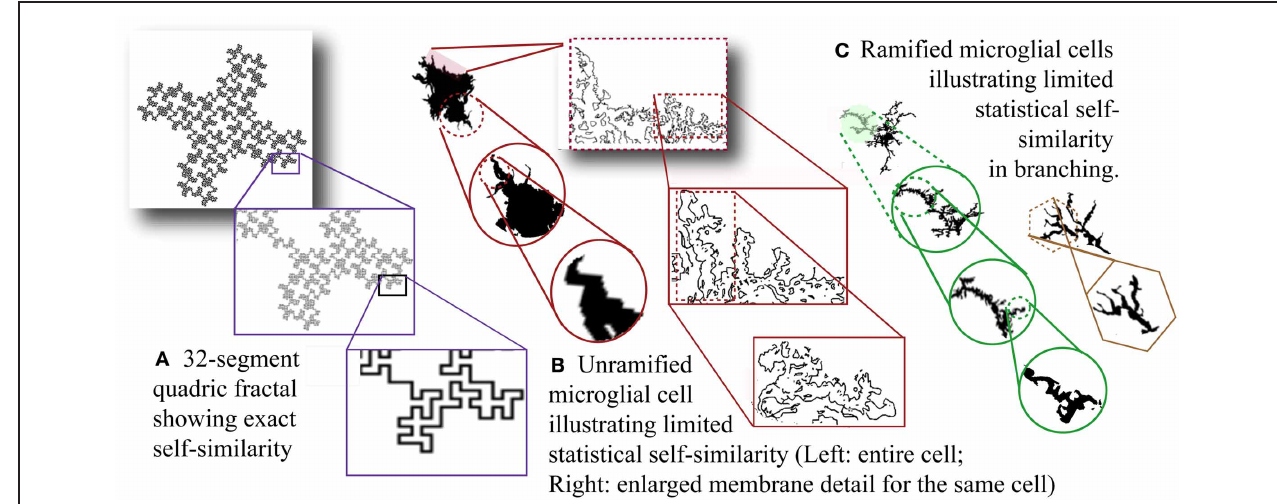
Silhouettes of (B) unramified and (C) ramified microglia. [Note that the rightmost figure in ( C) could be classified as intermediate.] (B) Showing membrane detail, and (C) showing branching detail, depict scaling that is not exactly self-similar and referred to as scale invariant. Moreover, scaling is only detectable within physical limits and the limits of the methods and media used to reveal morphology including staining and recording methods as well as magnification and resolution (both optical and